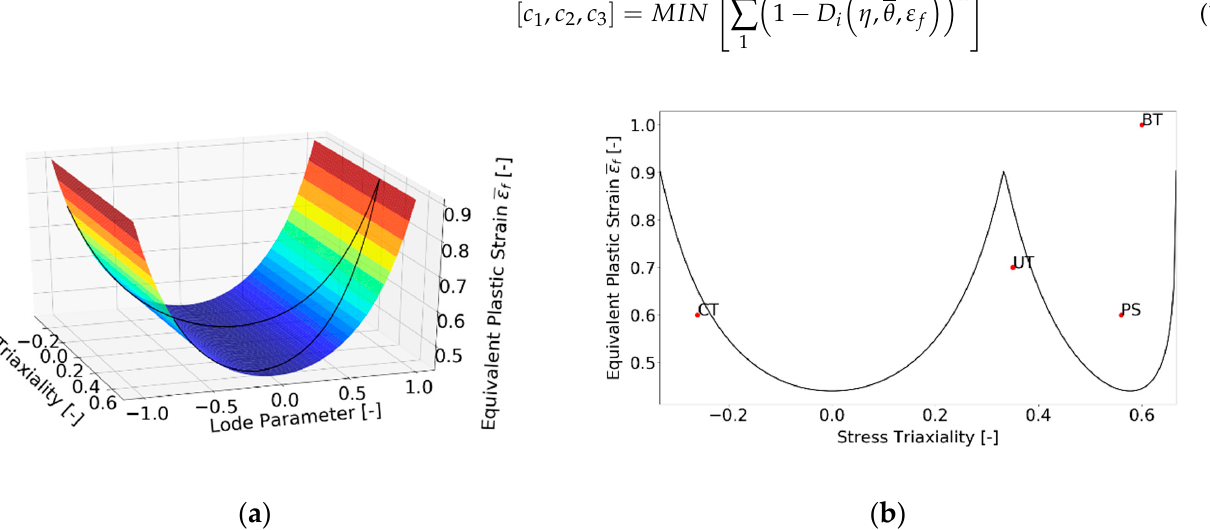
Figure 17. Fracture locus defined by MMC model of honeycomb ( a ) in Haigh-Westergaard space, ( b ) for plane stress condition.